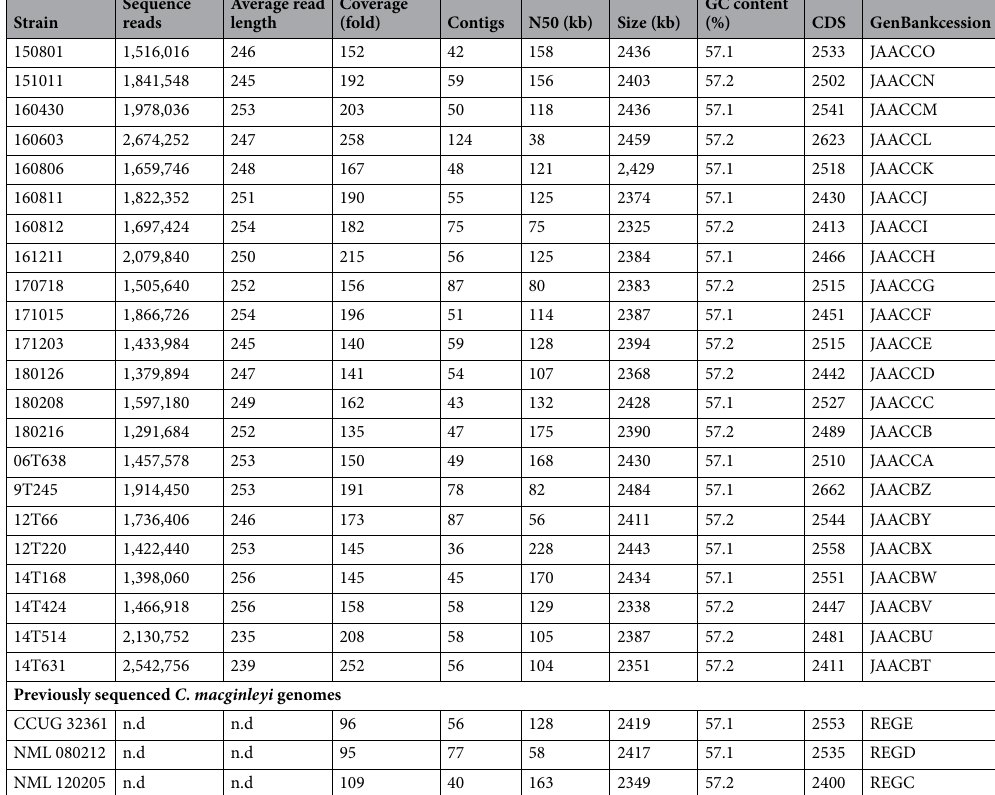
Table 3. Corynebacterium macginleyi genome